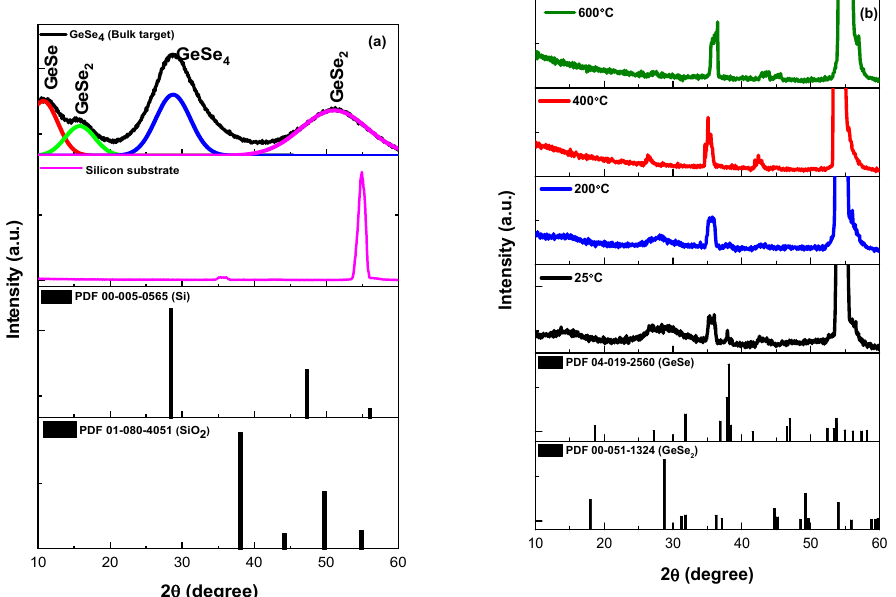
Figure 5. XRD patterns for ( a ) a pure silicon substrate (thickness = 675 µm) and GeSe4 bulk glass, ( b ) thin films fabricated on silicon glass substrates by fs-PLD at various substrate temperatures 25, 200, 400, and 600 °C.